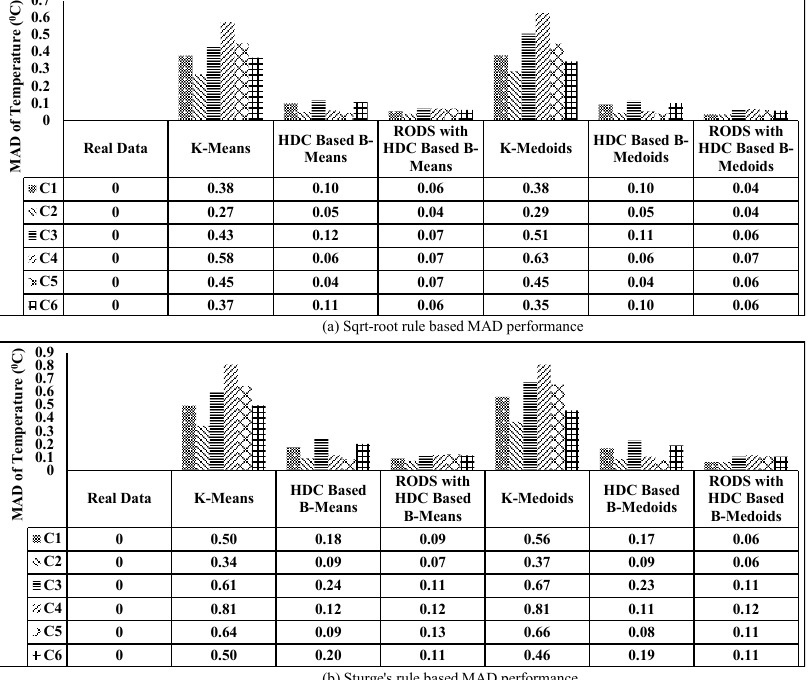
Figure 21. Performance comparison of all evaluated techniques in all selected clusters versus two different rules. ( a ) MAD versus all selected clusters based on the square-root rule; ( b ) MAD versus all selected clusters based on Sturge’s rule.